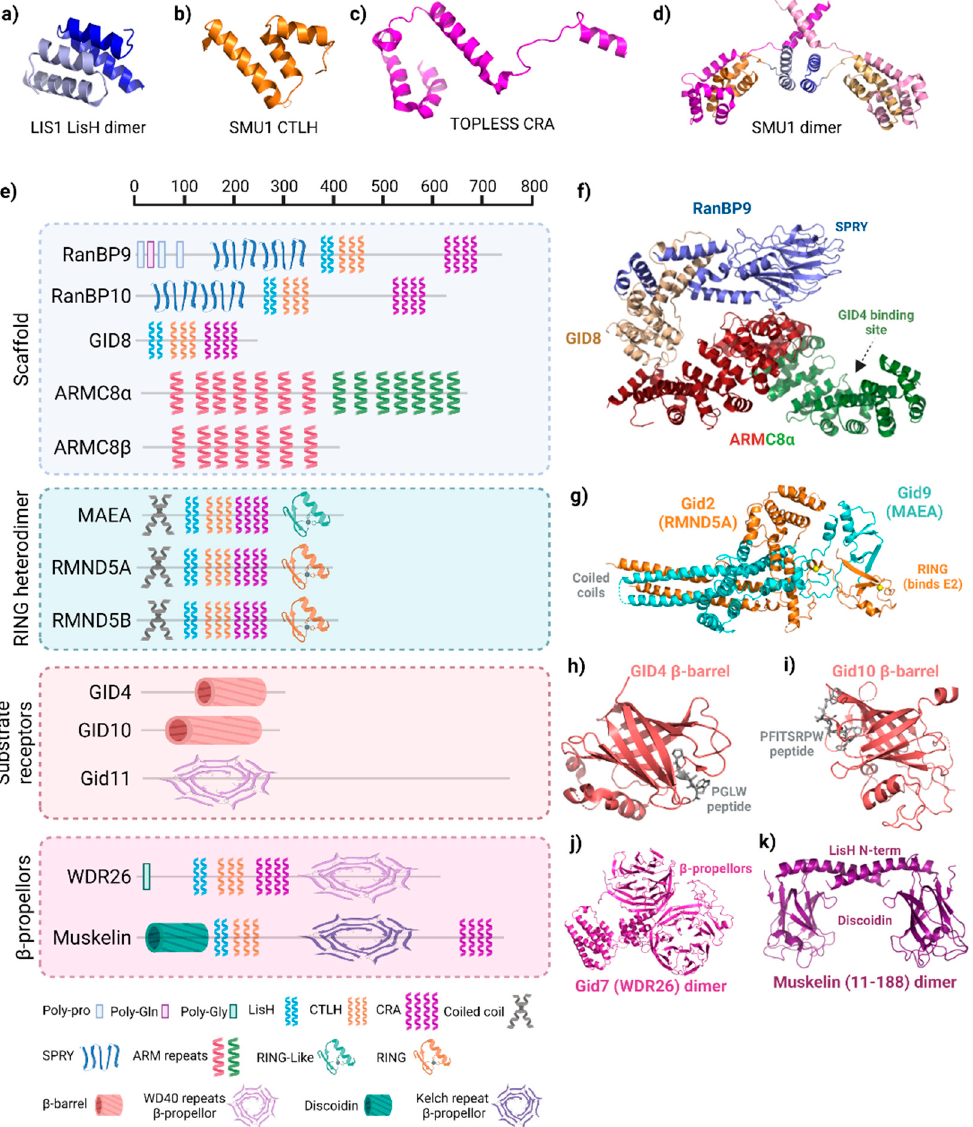
Figure 2. Structure of GID/CTLH subunits. ( a ) Lis1 lissencephaly type-1-like homology (LisH) dimer (PDB: 1UUJ). ( b ) Smu1 C-terminal to LisH (CTLH) motif (PDB: 5EN8). ( c ) TOPLESS CT11-RanBPM (CRA) motif (PDB: 5NQV). ( d ) Structure of SMU1 LisH-CTLH-CRA dimer. LisH (light blue, blue), CTLH (orange, gold), and CRA (violet, pink) in each monomer are shown (PDB: 5EN8). ( e ) Domain organization of GID/CTLH subunits. Scale at the top reflects residue number. All proteins depicted are the human versions, except for Gid7, Gid10, and Gid11, which are S. cerevisiae. Legend below denotes the names of each domain and the corresponding symbol, which is representative of the domain structure. Created with Biorender.com (21 April 2022). ( f ) Structure of the RanBP9 (blue)– GID8 (gold)-ARMC8 α (red/green) scaffold in the human CTLH complex. ARMC8 is split into two colours where red represents structure shared between α and β isoforms, whereas green is only present in α . PDB: 7NSC. ( g ) Structure of the S. cerevisiae Gid2 (homologue of RMND5A/B) and Gid9 (homologue of MAEA) RING heterodimer. Zinc ions are coloured yellow (PDB: 7NS4). ( h ) Human GID4 β -barrel structure in complex with a PGLW peptide. (PDB: 6CDC). ( i ) S. cerevisiae Gid11 β - barrel structure in complex with a PFITSRPW peptide (7QQY) ( j ) Structure of the S. cerevisiae Gid7 (homologue of WDR26) dimer structure (PDB: 7NSB). ( k ) Structure of the N-terminus of a muskelin dimer encompassing the discoidin domain and first helix of the LisH (PDB: 4OYU). In the GID/CTLH complexes, Gid1 (RanBP9/10), Gid2 (RMND5A/B), Gid7 (WDR26),